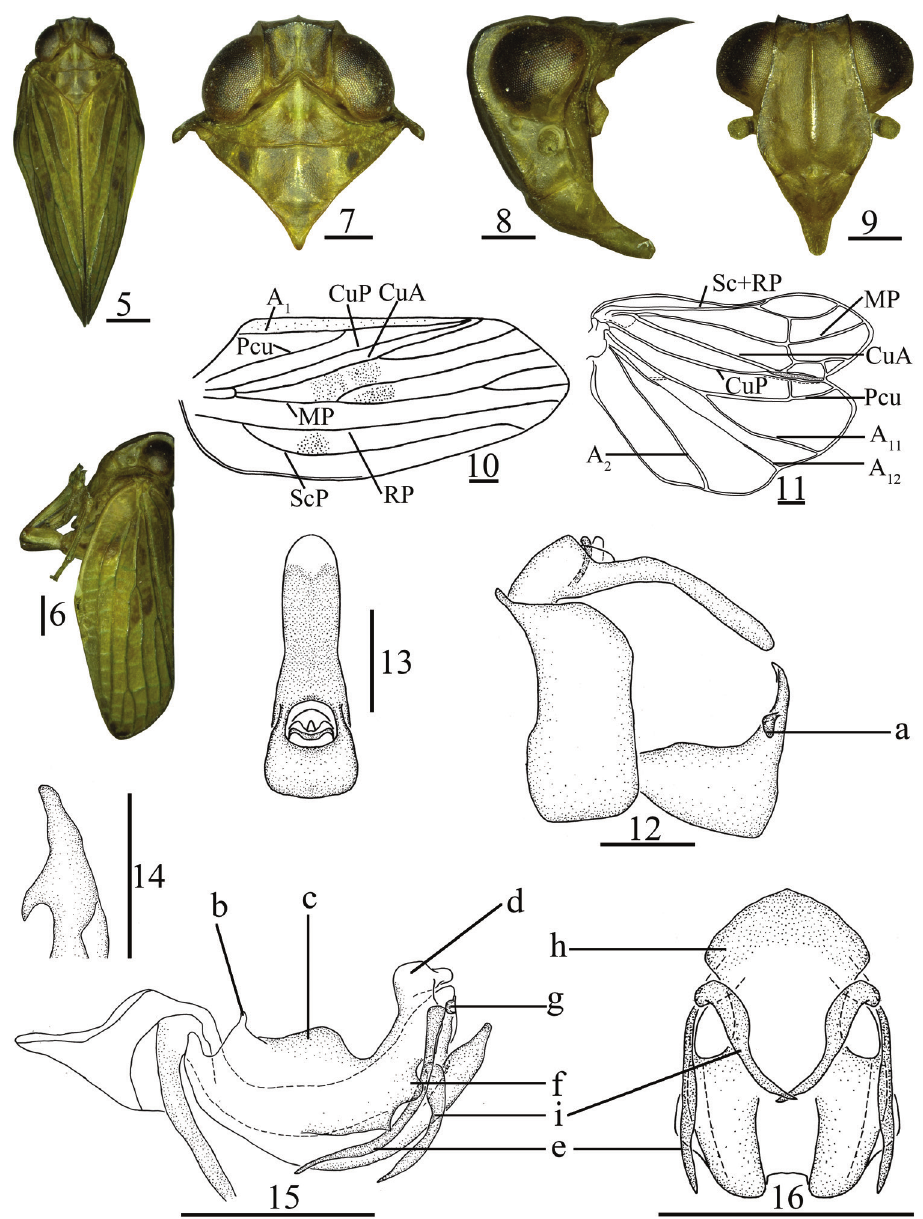
7 head and thorax, dorsal view 8 same, lateral view 9 head, ventral view 10 forewing 11 hindwing 12 male genitalia, lateral view 13 male anal segment, dorsal view 14 capitulum of genital styles, posterior view 15 ae- deagus and phallobase, lateral view 16 same, ventral view. Scale bars: 0.5 mm. Abbreviations: a–irregular triangular prominence, b–small claviform process, c–convex protrusion, d–duck mouth-liked process, e–long hooked process, f–lobe-like process, g–small lamina-like process, h–mushroom-liked, i–short hooked